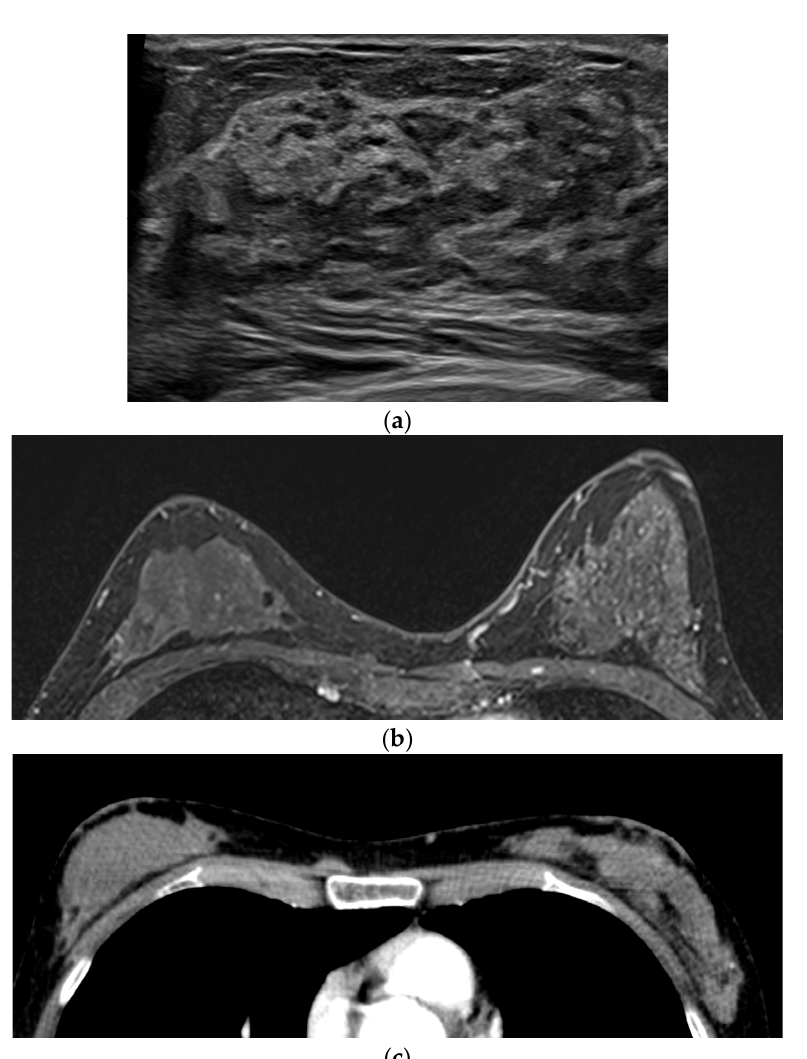
Figure 1. A 42-year-old woman with screening. ( a ) In the ultrasound, there was a 5.5 cm extent diffuse nonmass lesion at the right upper breast, and this lesion was confirmed as an invasive lobular carcinoma on core needle biopsy. ( b ) No discernible enhancing lesion at the right upper breast in the early phase of dynamic contrast-enhanced T1WI. ( c ) Also, no detectable enhancement at the correlating site in the contrast-enhanced chest CT.